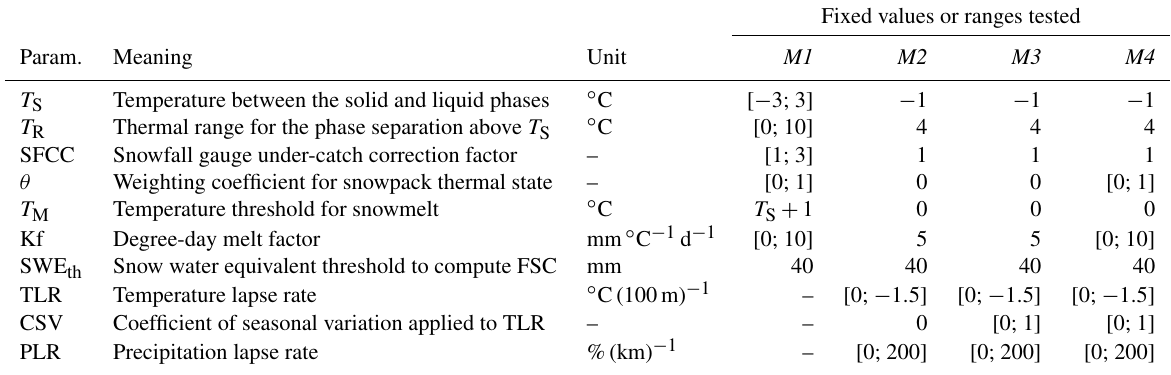
Fixed values or ranges tested